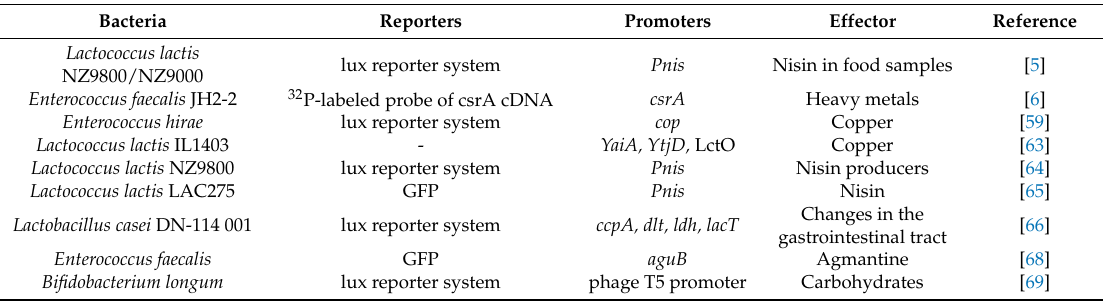
Table 1. Some examples of molecular biosensors in LAB and